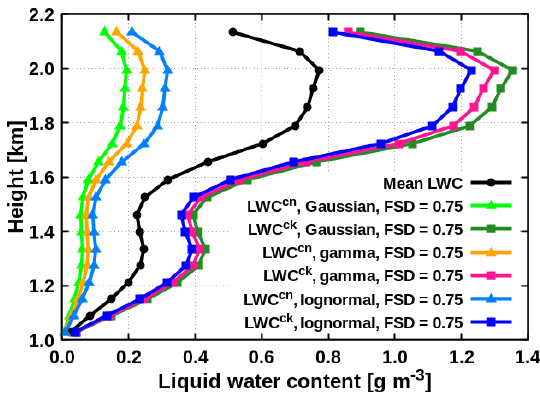
Figure 11. LWC profiles obtained with the FSD method using mean global estimate and altering LWC